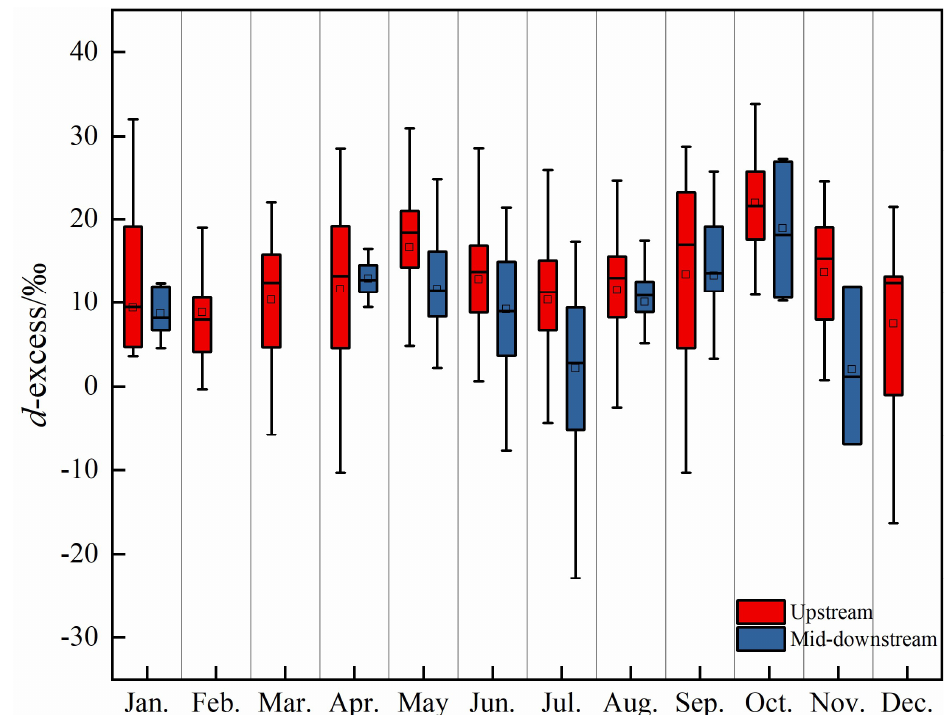
Figure 2. Temporal and spatial changes of d -excess in Shiyang River Basin.